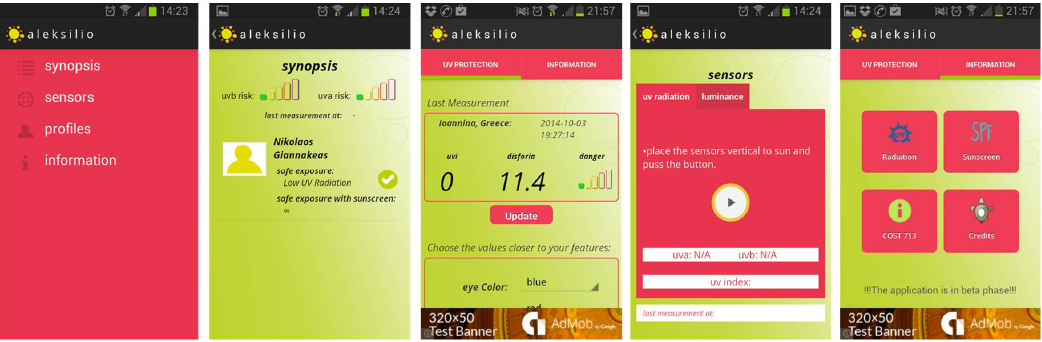
Figure 2. The mobile app’s main tabs. From left to right: the opening screen and the four main tabs: the synopsis of the users, users’ management, sensors readings and the general information.